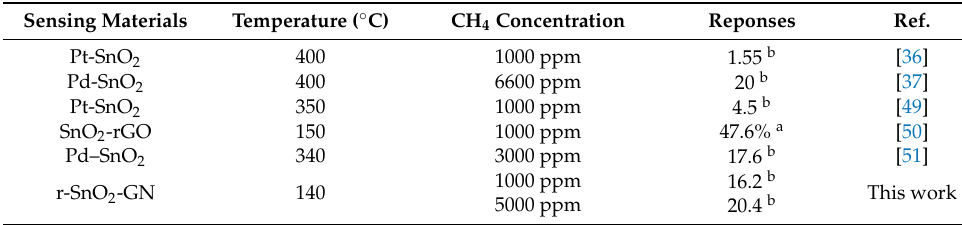
Table 2. The brief summary of sensing performance of SnO 2 -based CH 4